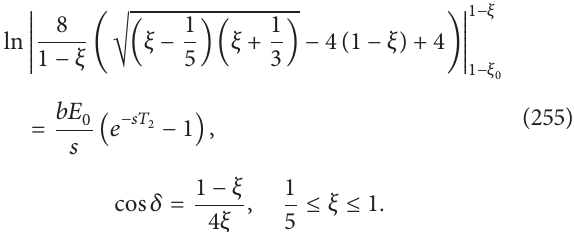
coordinates 𝜉 = 0 , 𝛿 = 2𝜋/3±𝜋𝑛 ( 𝑛 = 0, 1, 2, . . . ). One